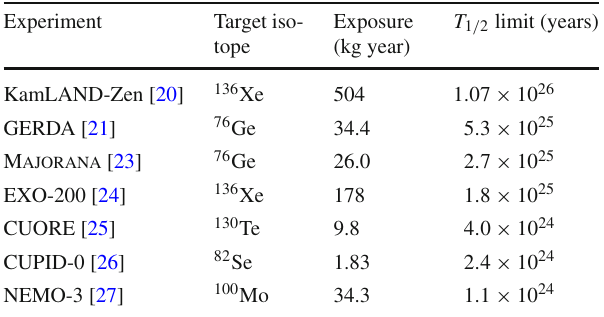
Fig. 1 A detector module for AMoRE-Pilot experiment. It is comprised of three main parts: a doubly enriched 48depl Ca 100 MoO 4 crystal, a photon detector, and phonon detector. Figure from